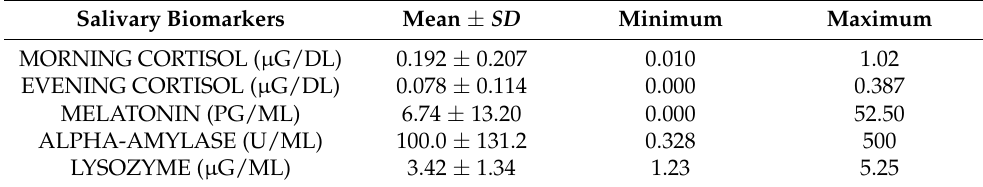
Table 3. Levels of salivary biomarkers. Salivary Biomarkers Mean ± SD Minimum Maximum MORNING CORTISOL ( µ G/DL) EVENING CORTISOL ( µ